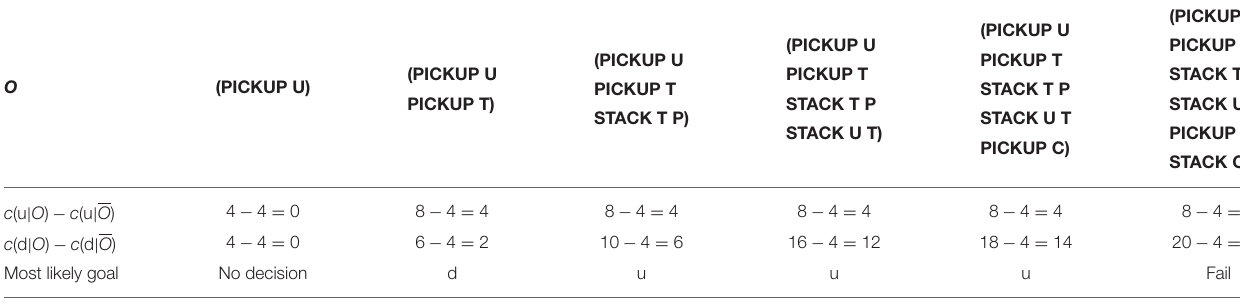
TABLE 2 | Observer modeled as a Plan Recognition agent for the Blocks Words example in Figure 2A